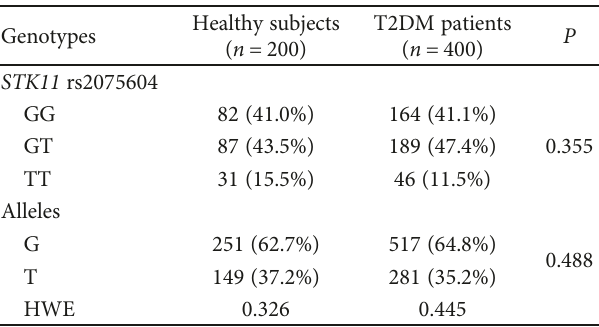
Table 2: Comparisons of allelic frequencies of STK11 rs2075604 polymorphisms in T2DM patients and healthy subjects.